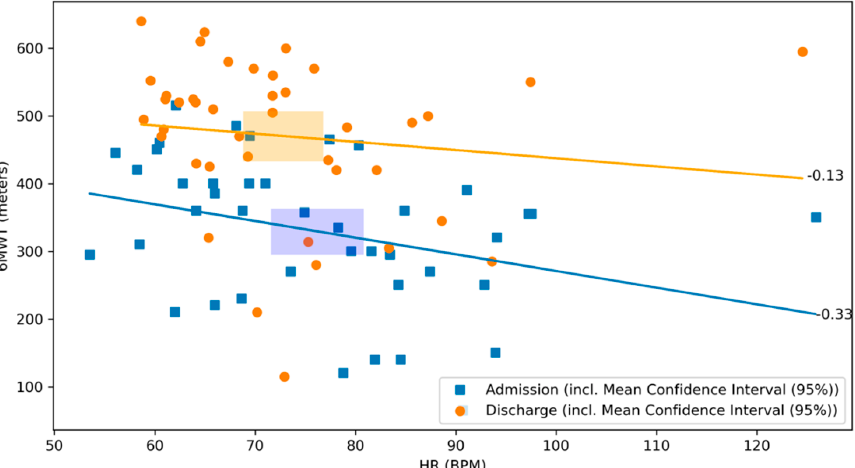
Figure 6. Scatterplot of 6MWT and heart rate at admission and discharge with respective correlation coefficients. The relationship between the 6MWT and the heart rate at admission (blue) and discharge (orange) of the CR stay are illustrated. The graph visualizes their respective correlation coefficients. Blue dots represent patients at admission, whereas orange dots represent patients at discharge. The lines depict the correlation coefficient between the 6MWT and the heart rate at admission in blue and at discharge in orange. The rectangles represent the mean confidence intervals of the respective means (r = − 0.33, p = 0.03 and r = − 0.13, p = 0.41,